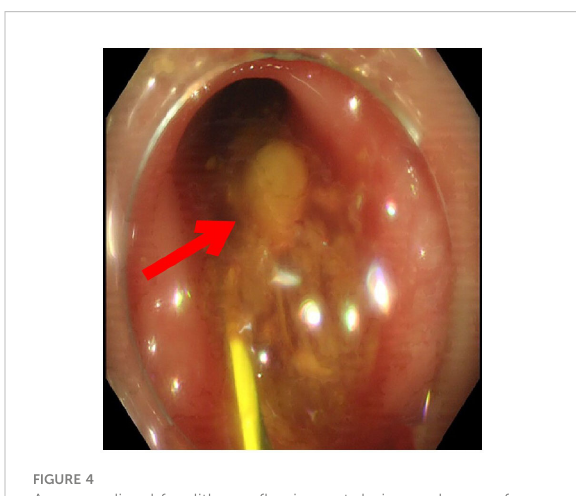
FIGURE 4 An appendiceal fecalith was fl owing out during exchange of